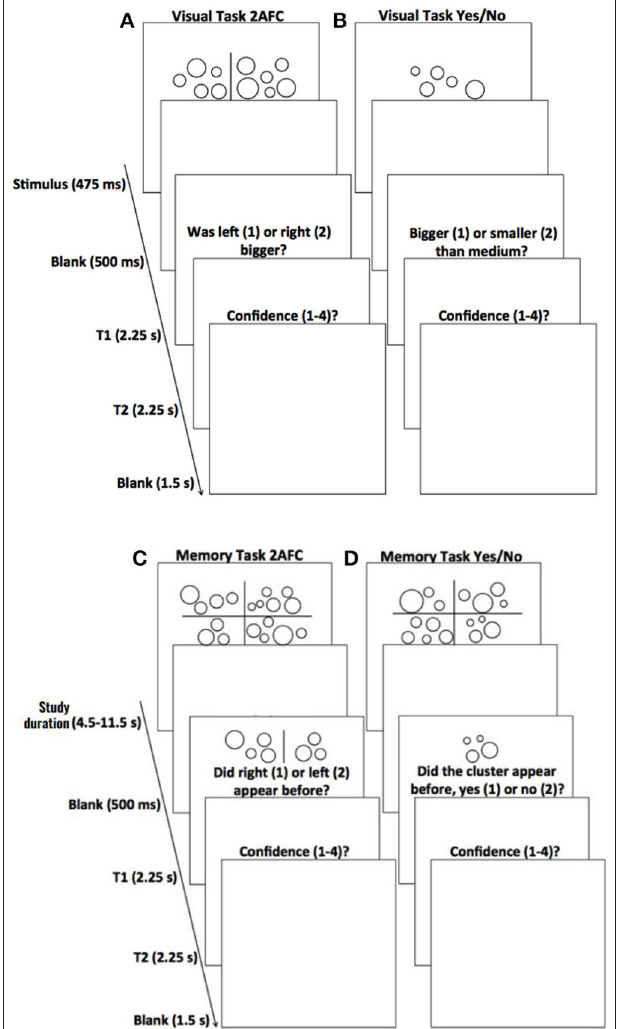
FIGURE 1 | Timeline for individual trials on the various tasks. (A) Visual task with 2AFC judgments. Subjects were shown two clusters of circles, followed by a blank screen, and were then prompted to discriminate whether the cluster with (on average) larger circles was on the left or right (T1). They then rated how confident they were on a scale of 1–4 (with 1 being not at all confident and 4 being completely confident) in their discrimination judgment (T2). A blank screen ended the trial. (B) Visual task with YN judgments. Each visual task trial requiring YN judgments was identical to trials for the 2AFC visual task, except that subjects were shown only one cluster, and were later prompted to discriminate whether the cluster had (on average) larger circles than a cluster of “medium” size (T1). (C) Memory task with 2AFC judgments. Subjects were shown four patterns of circles, followed by a blank screen. Next, two patterns were presented, one from the previous stimulus presentation and one new pattern; participants were instructed to pick the pattern that appeared before (T1). As with the visual tasks, they then gave confidence judgments on a scale of 1–4 (T2). A blank screen ended the trial. (D) Memory task with YN judgments. Each memory task trial requiring YN judgments was identical to trials for the 2AFC memory task, except that only one pattern was presented during the discrimination portion of the task and subjects were instructed to determine whether it had appeared on the previous stimulus presentation or not